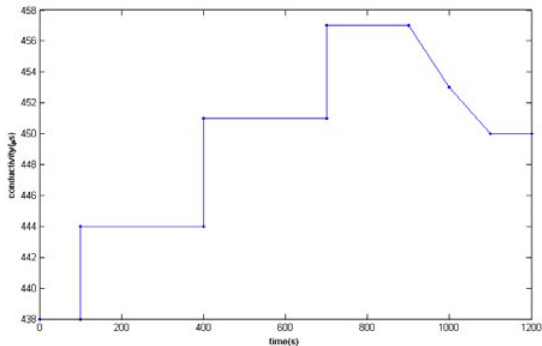
Fig. 1. Conductivity trend in crystal nucleation